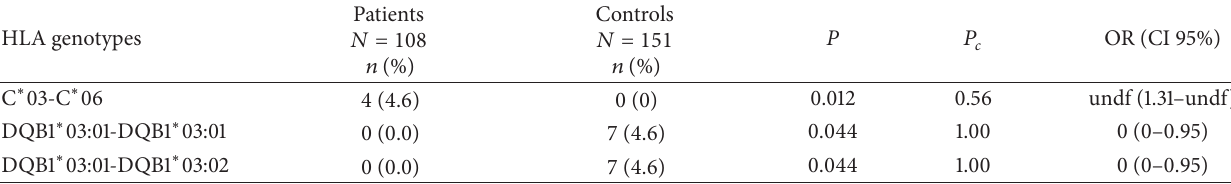
Table 3: HLA genotype frequency associations between chronic periodontitis patients and controls ∗ . HLA genotypes